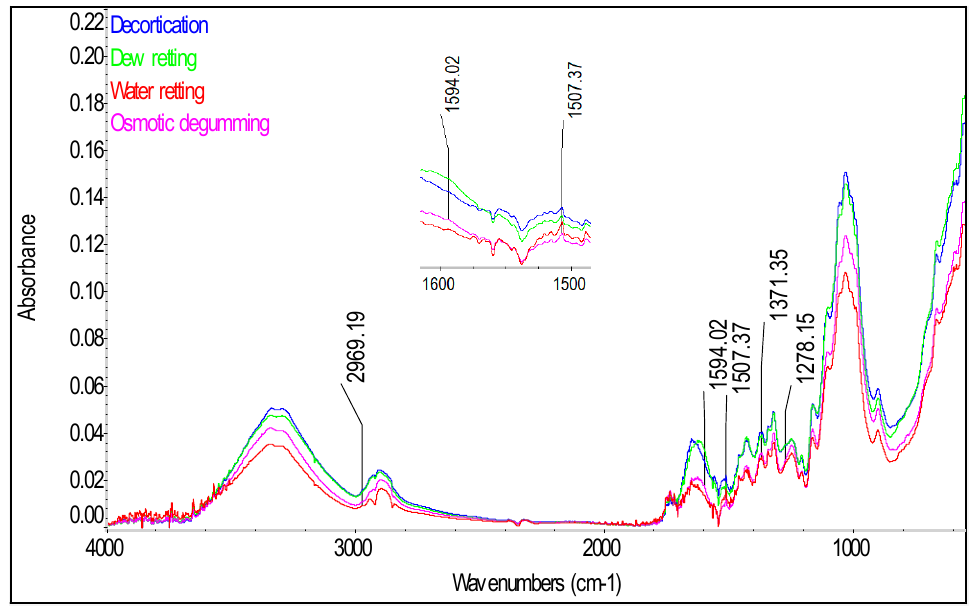
Figure 9. The Fourier transform infrared Attenuated Total Reflection spectra of the Białobrzeskie variety, hemp fiber after decortication, dew retting, water retting and osmotically degumming. Table 5. The characteristics of the main absorbance spectra in FTIR of flax fiber.